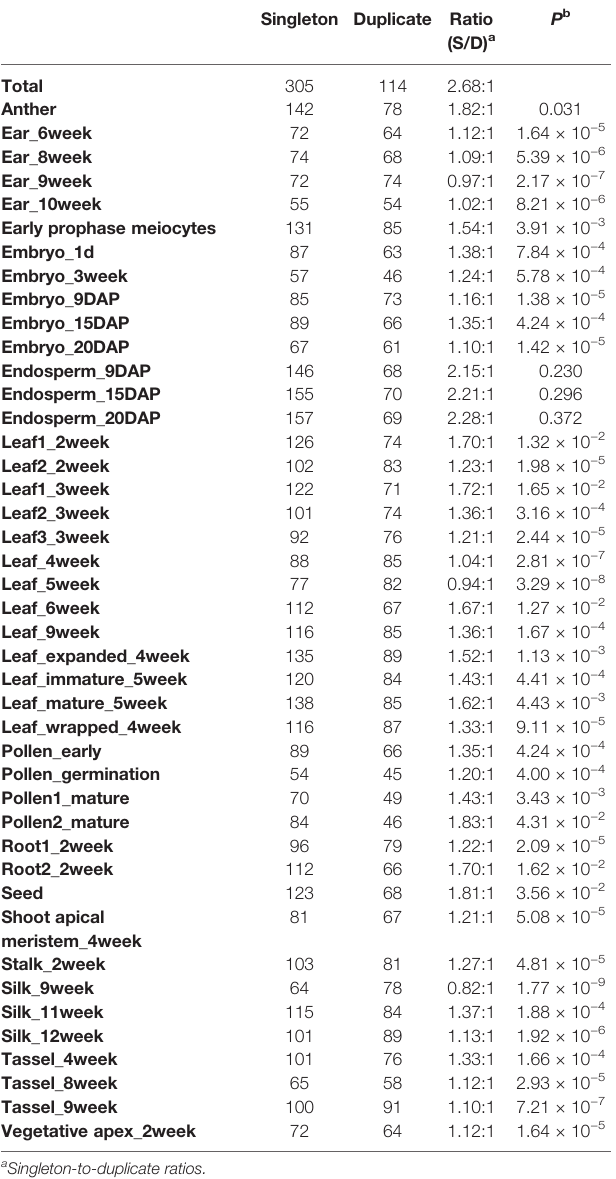
TABLE 2 | Statistical analysis of singleton-to-duplicate ratios of miRNA genes in individual tissue samples.